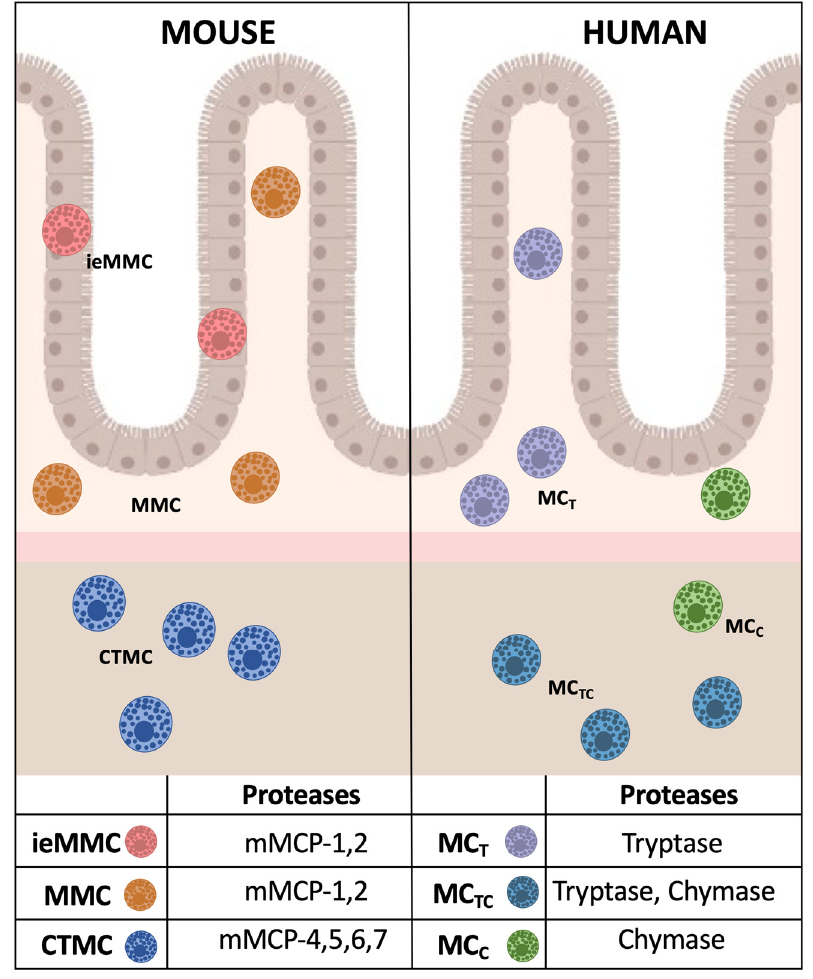
Figure 1. Mast cell subsets in murine and human gut. Mast cell subsets identified in murine intestine ( left ) and human intestine ( right ), and their distribution are represented with different colors. Proteases expressed by the different MC subsets are listed in the table below. ieMMC: intraepithelial mucosal mast cells, MMC: mucosal mast cells, CTMC: connective tissue mast cells, MC T , MC TC , MC C : Mast cells expressing tryptase, tryptase and chymase, chymase only, respectively.